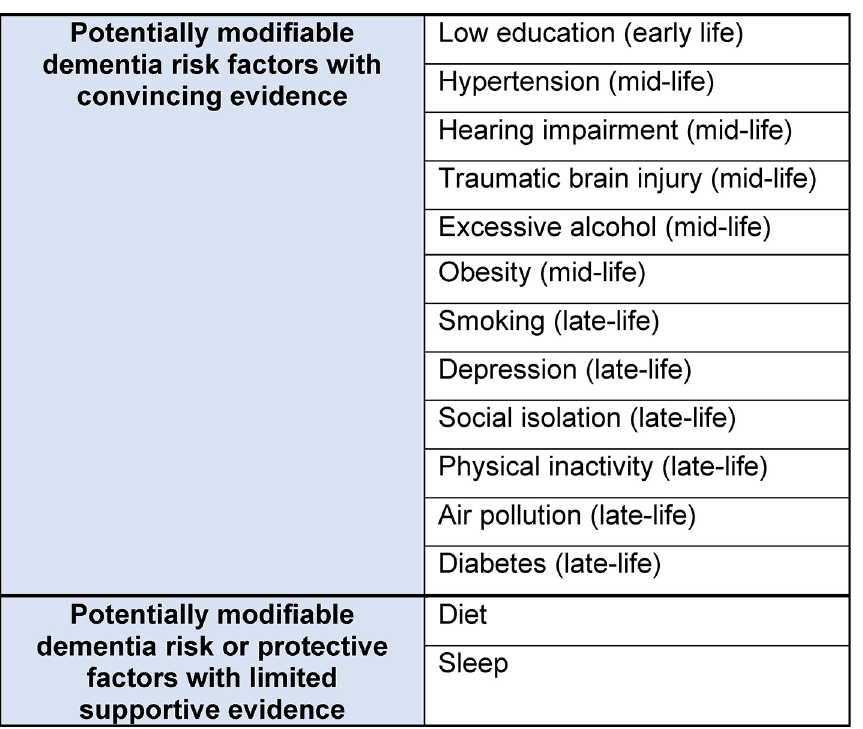
Fig 1. Dementia modifiable risk factors. Modifiable risk factors from major guidelines and strength of supportive evidence. Adapted from [3].